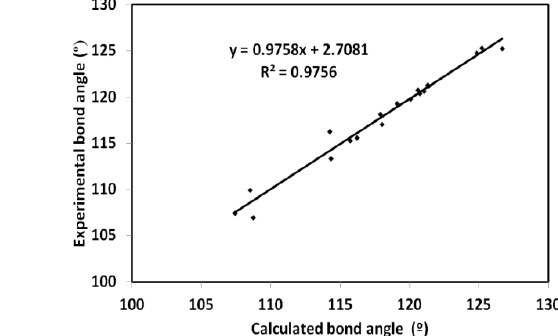
Figure 8. Correlations between the optimized and experimental geometric parameters.